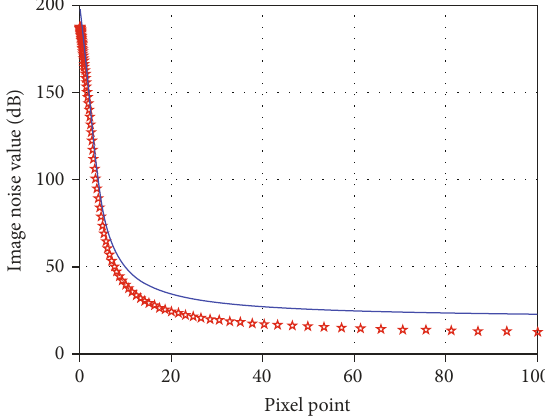
Figure 6: The trend of image noise value changes with pixel